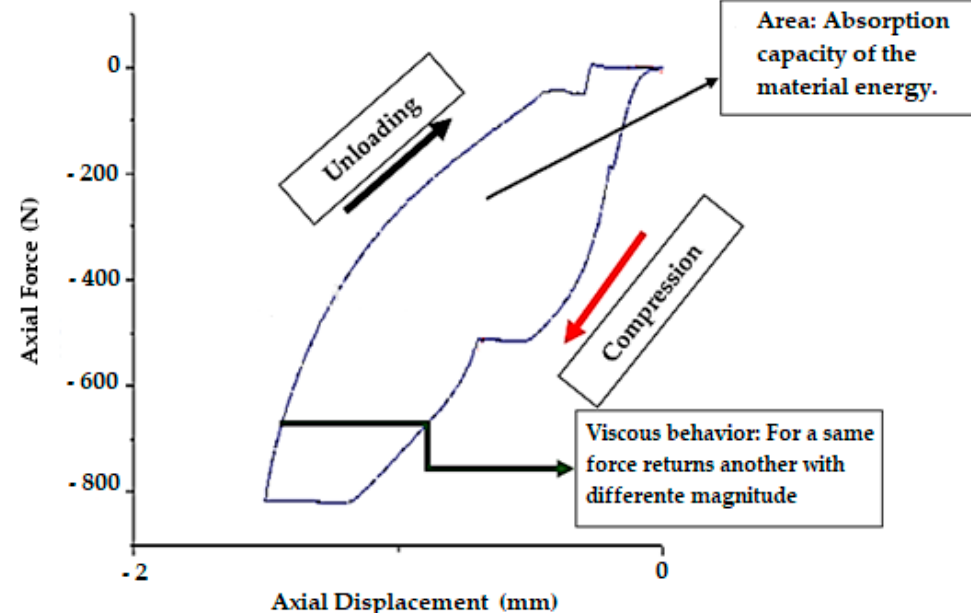
Figure 3. Representation of the material studied, in which the line of loading and unloading is apparent, leaving the energy dissipated between both (damping) (Static test).